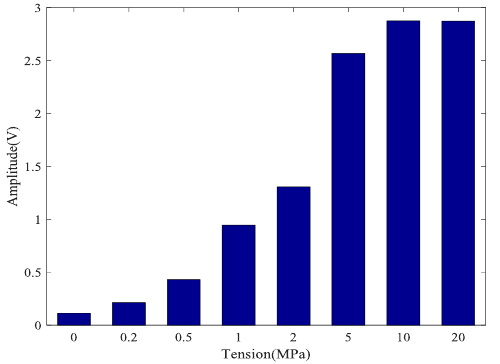
Figure 10. Focused signal based on times reversal for five repeated tests.